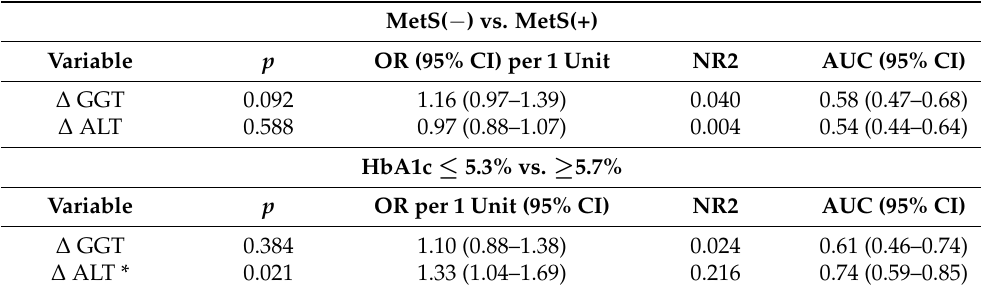
Table 4. Univariable logistic regression analysis for MetS and HbA1c ≥ 5.7% prediction by postpran- dial changes in the activity of aminotransferases. MetS( − ) vs.